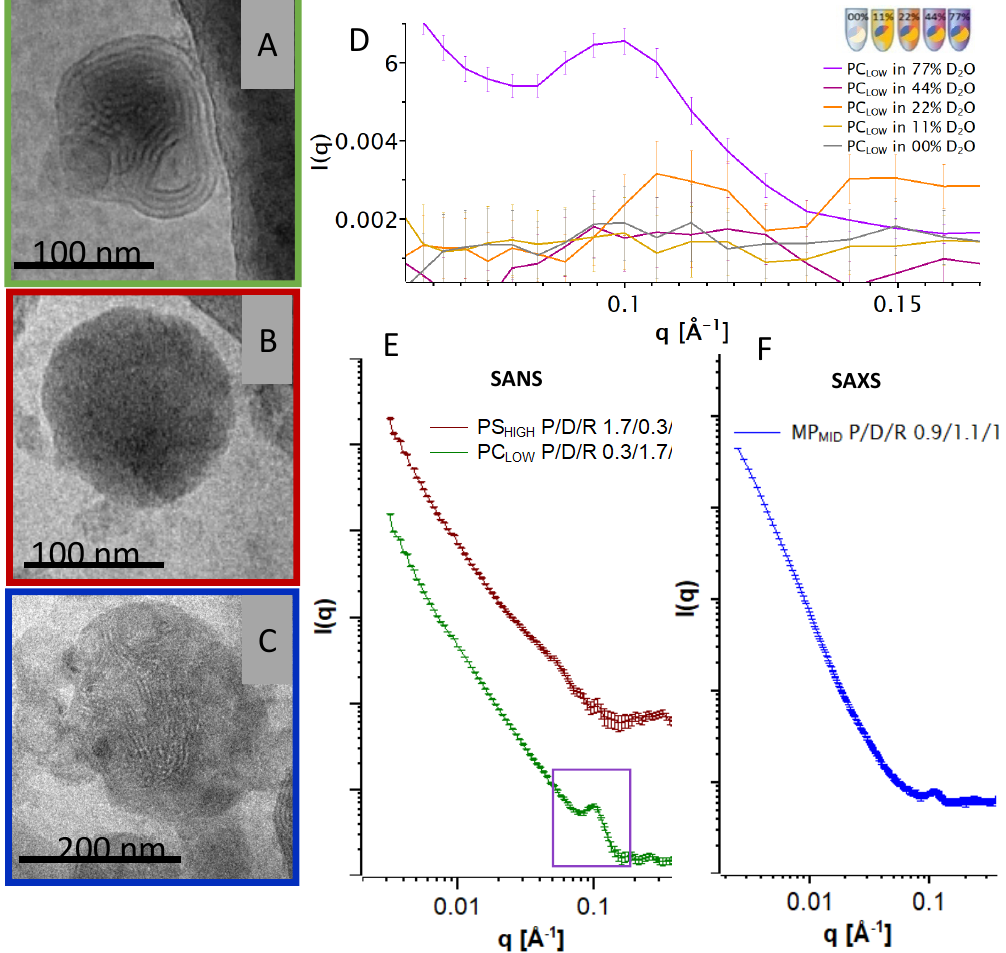
Figure 4. ( A – C ) Cryo-TEM pictures of the respective particles shown in the same colour as the corresponding curves. ( D ) Intensity scattering of PC LOW particles in a q-range of 0.03–0.18 Å − 1 at different D 2 O concentrations. The peak at 0.1 Å − 1 is present when the scattering length density of the buffer diverges from the scattering length density of the lipid. ( E ) Double logarithmic plot of SANS scattering of PC LOW (N/P 0.3/1.7/1) and PS HIGH (N/P 1.7/0.3/1) at 77% D 2 O. Curves were shifted vertically for clarity. ( F ) Double logarithmic plot of the SAXS curve of MP MID .